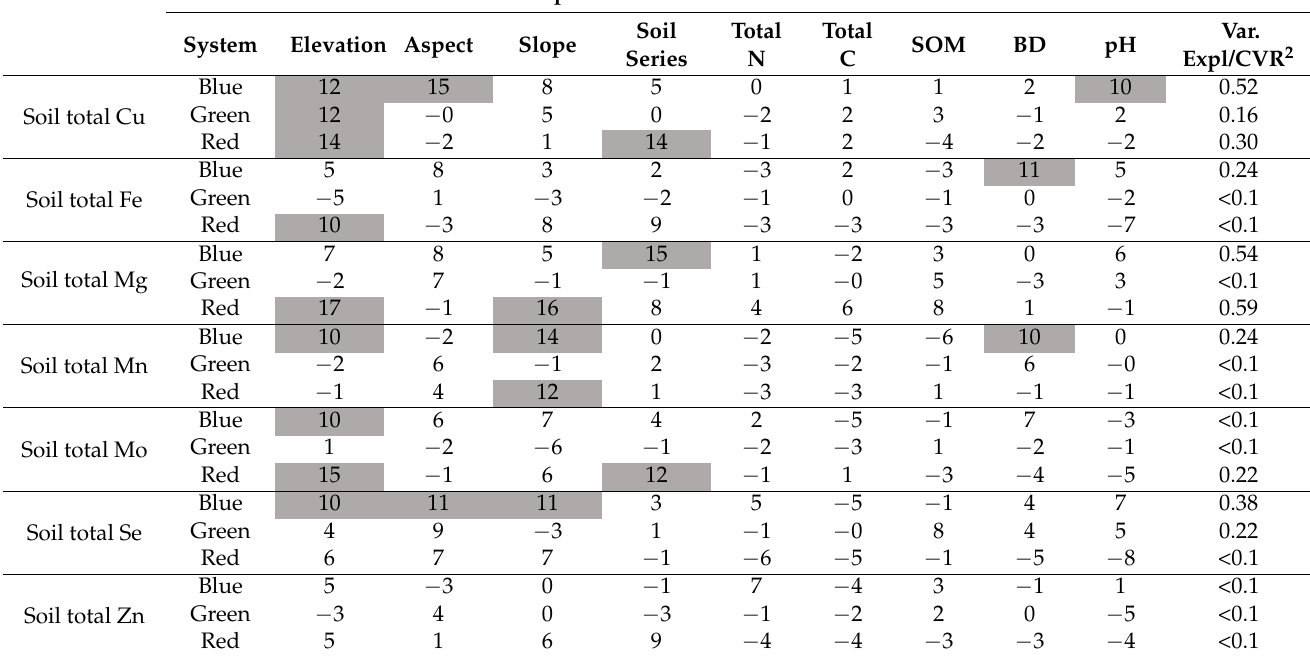
Table 3. Cross-validation performance of the site/soil calibration models predicting soil total micro-nutrient concentrations in the blue/HSG + L, green/P + N and red/HSG + N pasture systems: % Inc MSE (increase in MSE if the variable is excluded), and total variance explained by each model (CVR 2 ). WE = water extractable. Dark grey highlight ≥ 10% increase in MSE when excluded from the model.